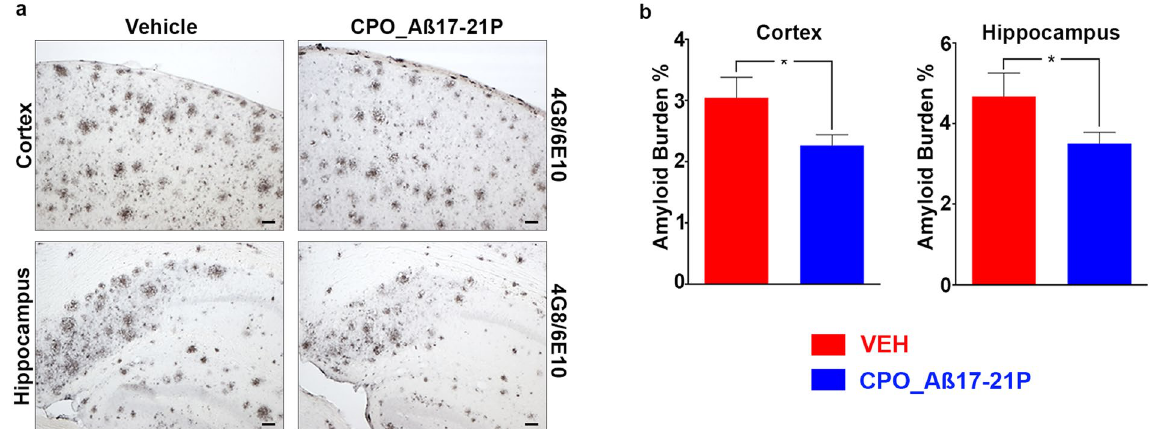
Figure 5. Amyloid- β plaque burden on brains of APP/PS1 mice treated with peptoid CPO_ A β 17-21 P or vehicle alone. ( a ) Treatment with CPO_ A β 17-21 P decreased cortical and hippocampal burden in APP/PSI mice. Scale bars represent 100 μ m. ( b ) There was a significant reduction observed in 6E10/4G8 immunoreactivity in both cortex and hippocampus in the CPO_ A β 17-21 P treated mice versus vehicle treated mice, * p < 0.05, one-tailed unpaired t